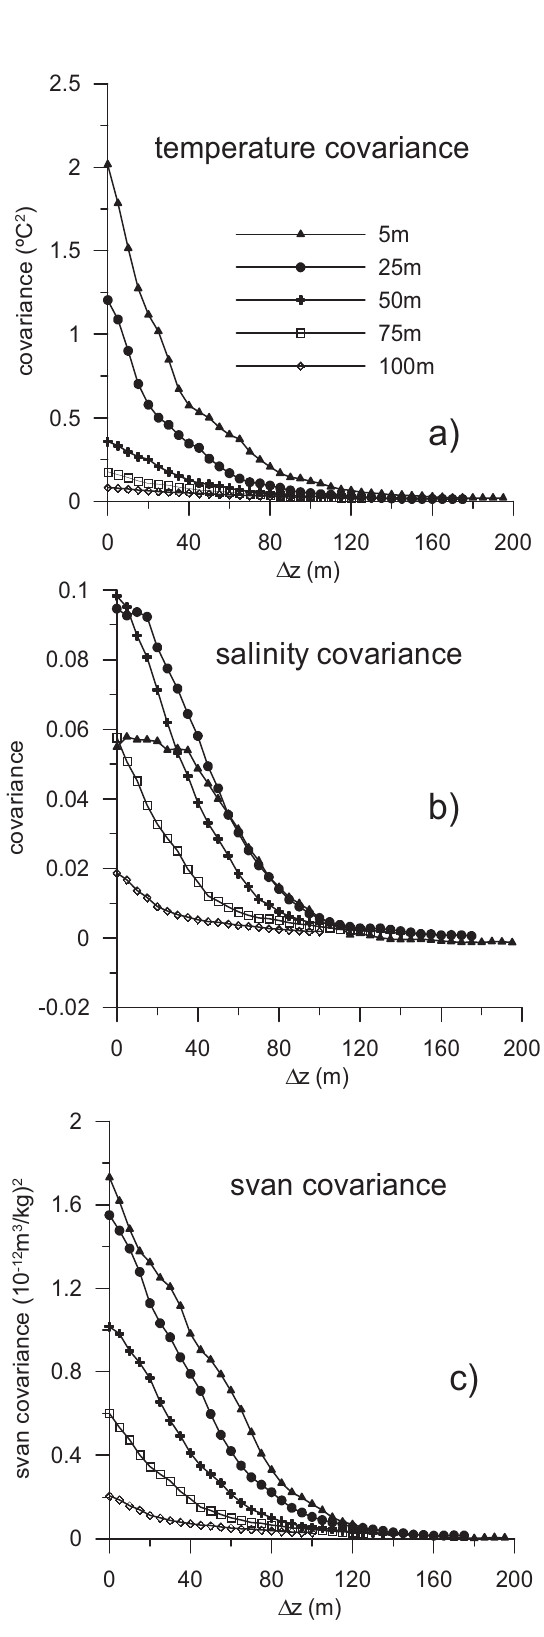
F IG . 5. – Covariance as a function of the depth difference between pairs of points with the same horizontal coordinate. Different curves correspond to different depths of the initial ESTIMATION OF PARAMETERS FOR OPTIMAL STATISTICAL INTERPOLATION 443